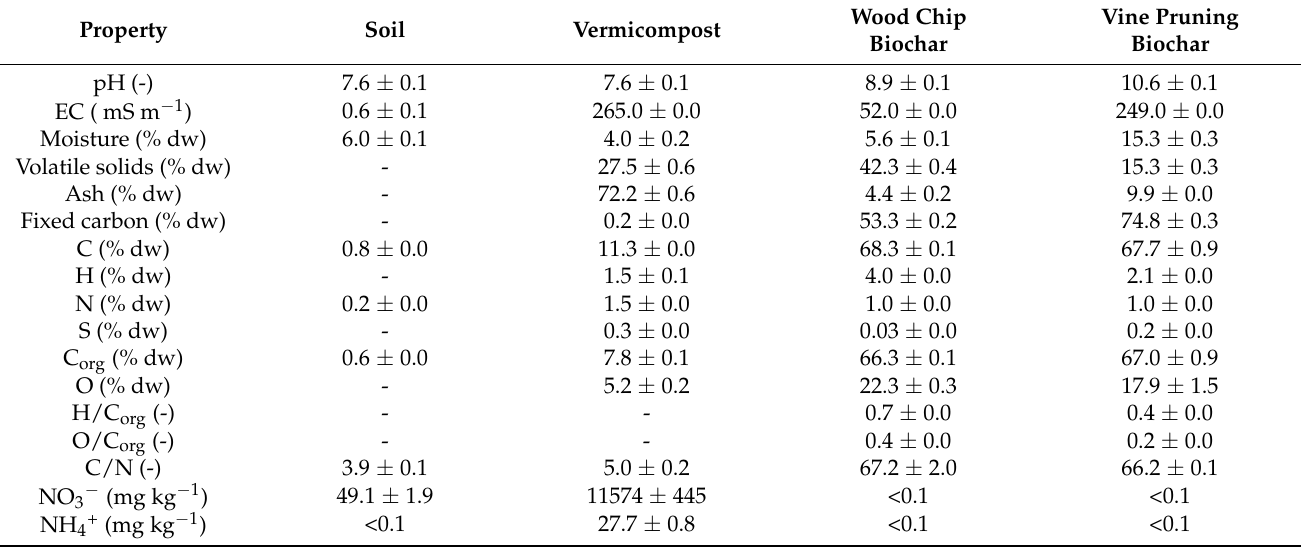
Table 2. Main physicochemical properties of the soil, vermicompost and biochars used in the